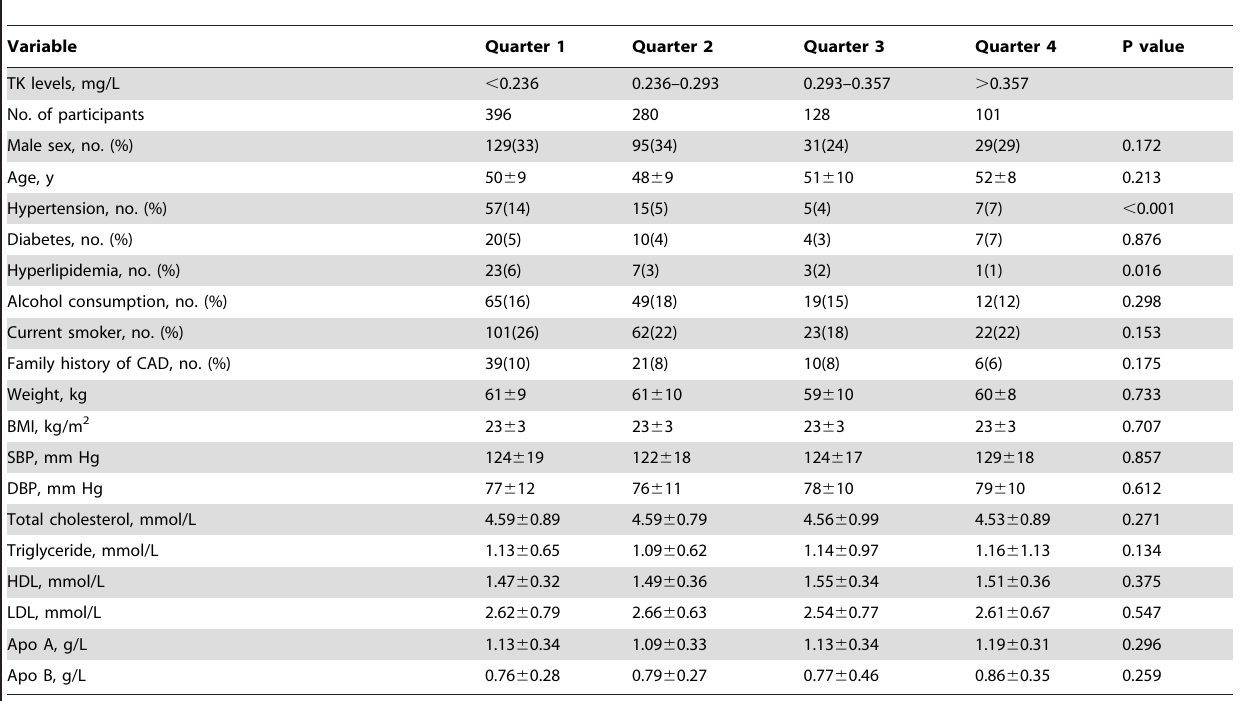
Table 2. The relationship between TK levels and cardiovascular disease risk factors in controls subjects.